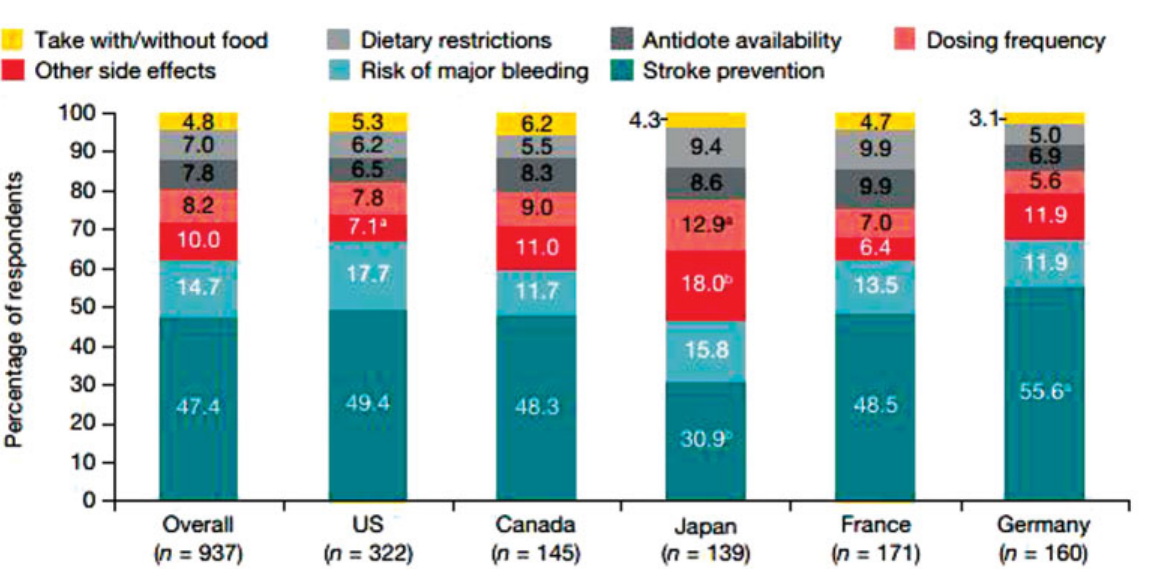
Fig. 2 The most important factor in the choice of oral anticoagulation rated by atrial fi brillation patients for the cohort overall and by country. a p < 0.05 versus other countries pooled. b p < 0.001 versus other countries pooled. Percentages do not always equal to 100 due to rounding.